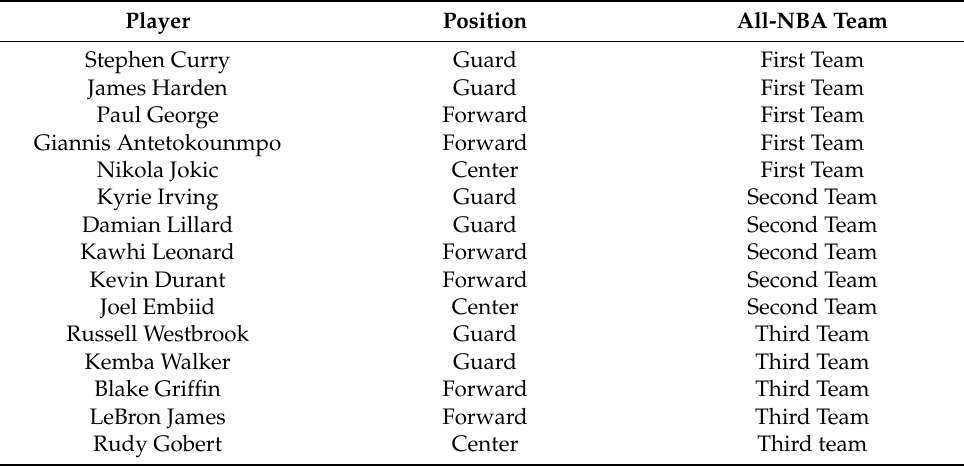
Table 4. Players selected to the All-NBA Teams in the 2018-19 NBA season. Player